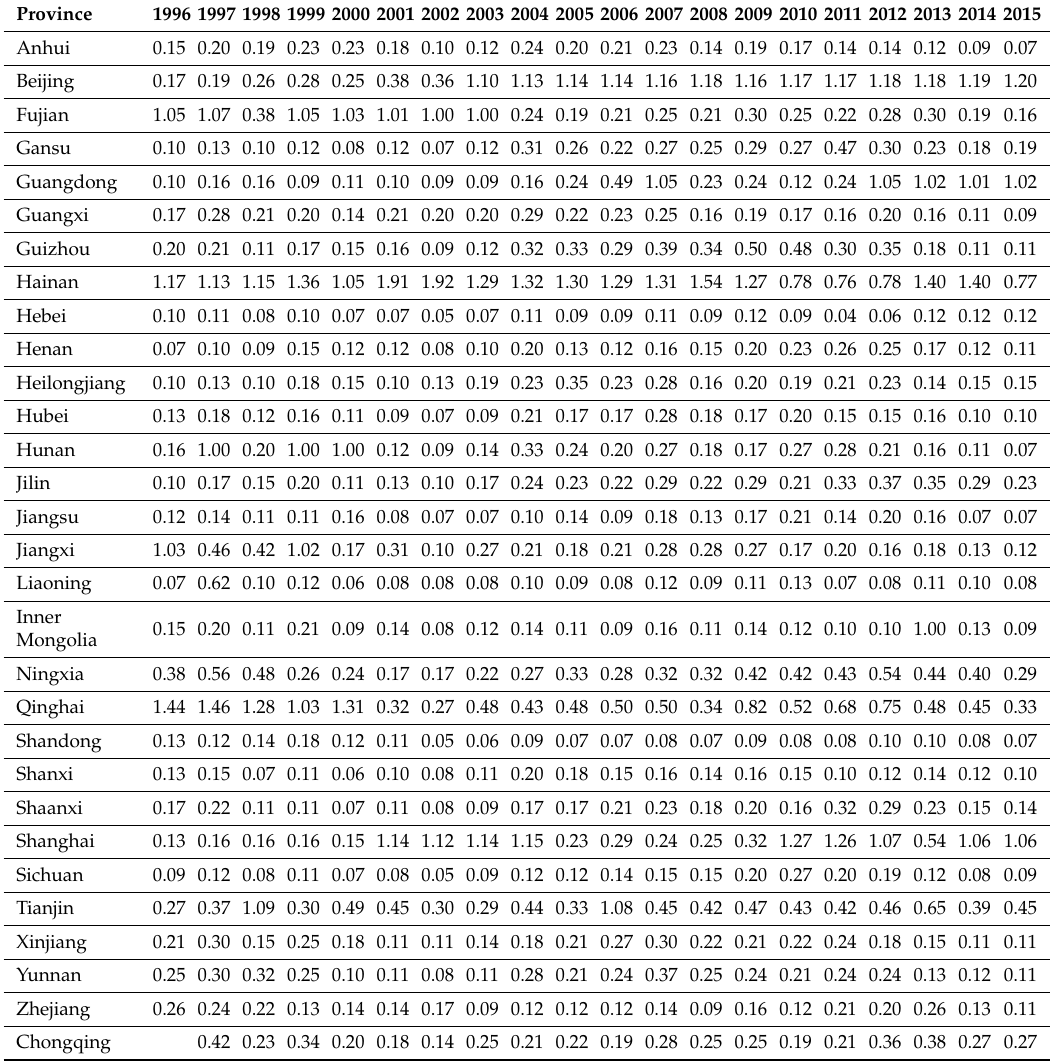
Table 2. China’s provincial comprehensive eco-e ffi